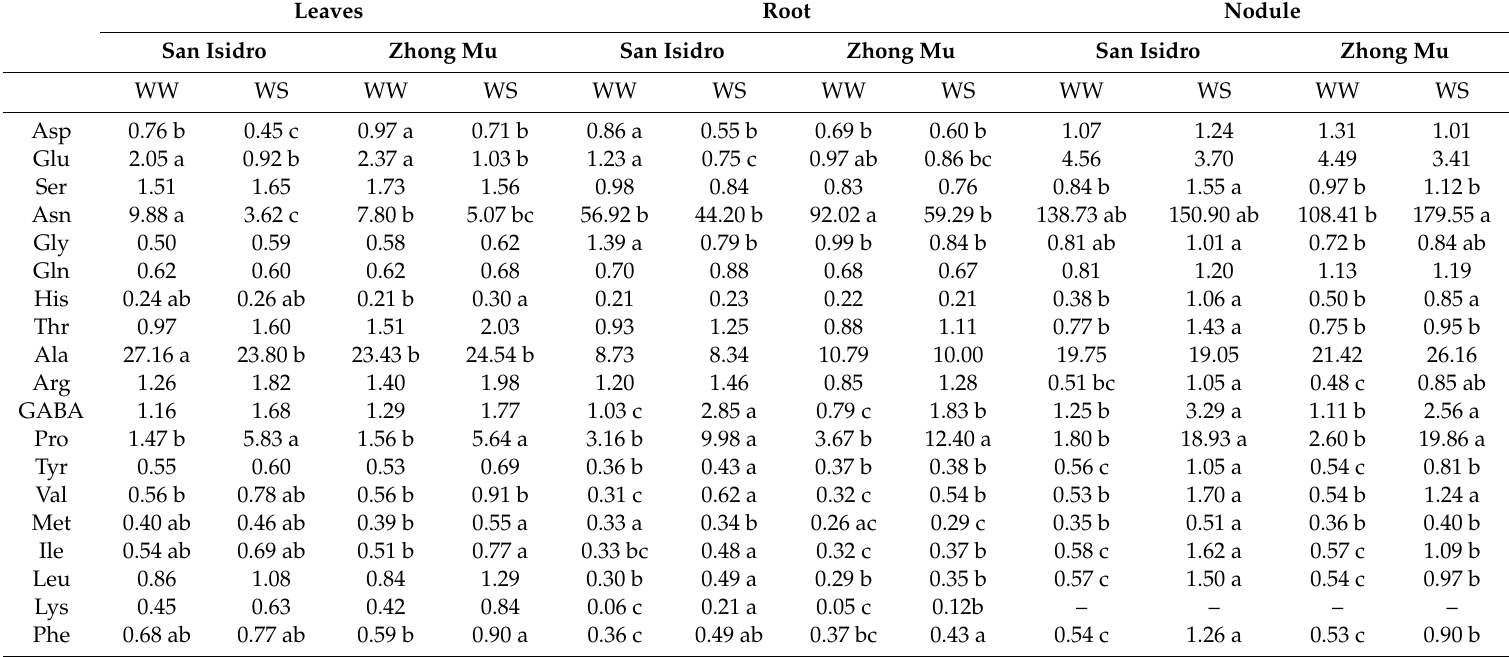
Table 1. Amino acid quantification (nmol / g DW) in leaves, roots and nodules of Medicago sativa under well-watered (WW) and water-stressed conditions (WS) determined by